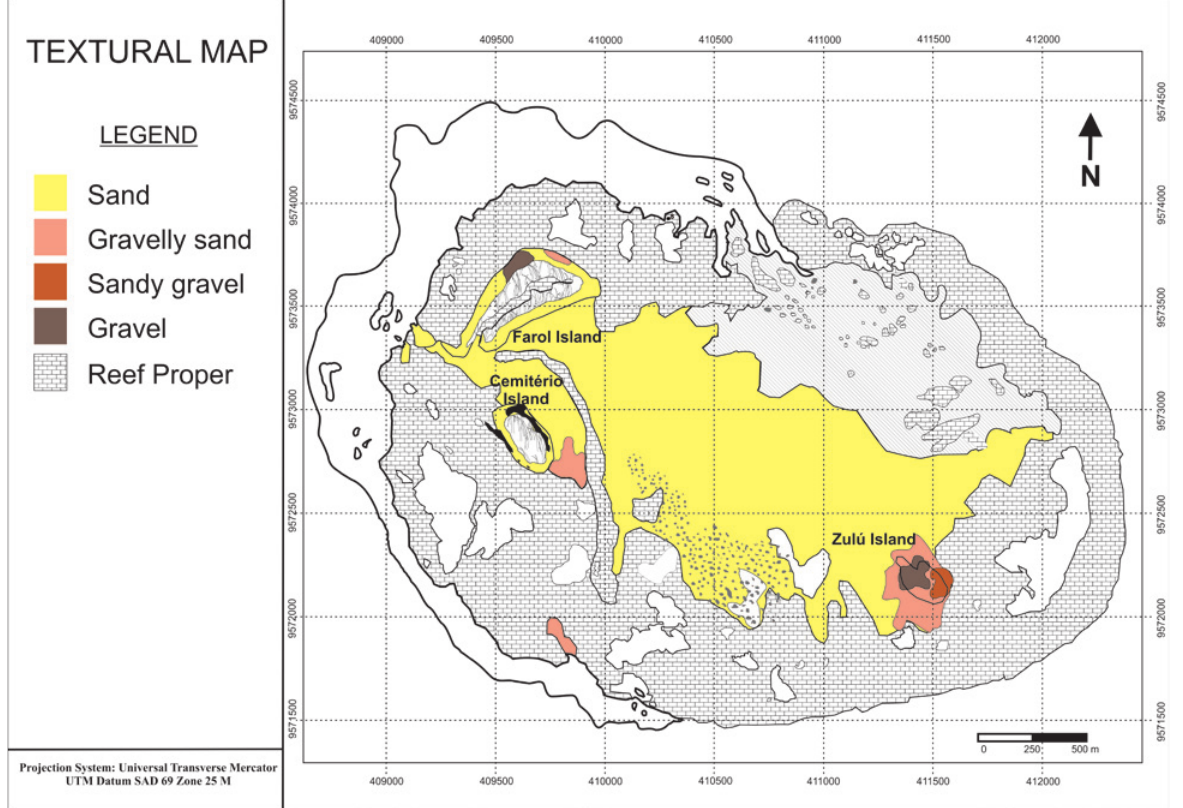
Figure 07 - Textural map of the Rocas